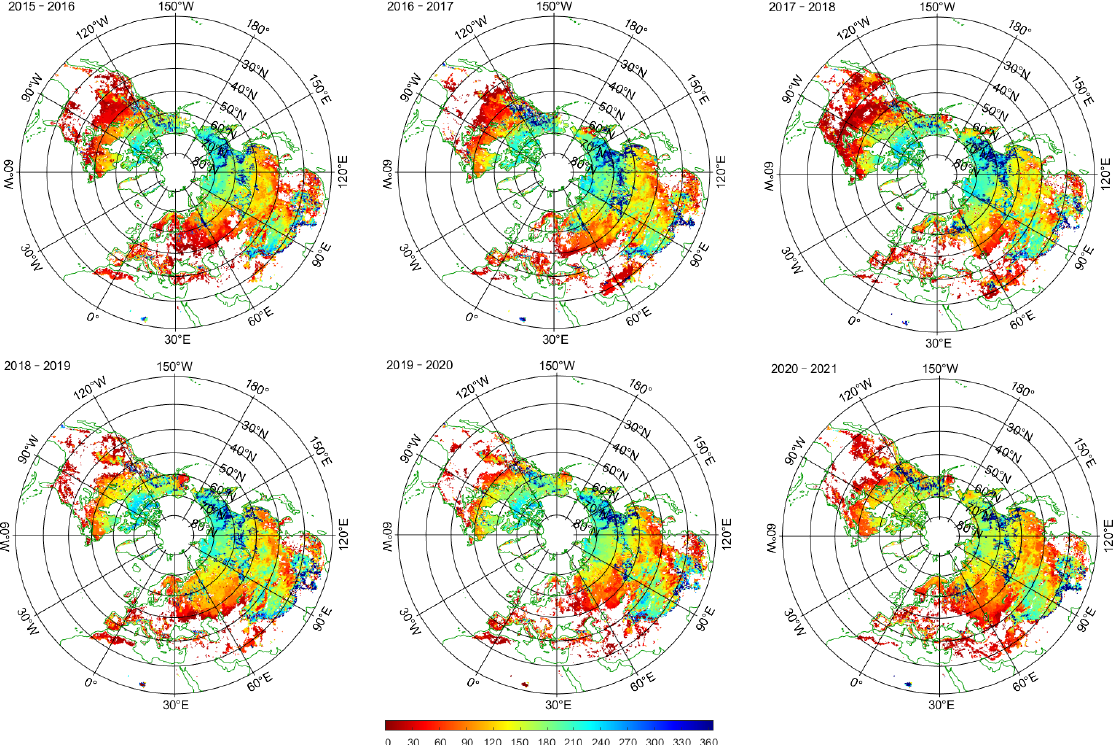
Figure 7. The duration of the frozen period inferred from the SMAP L3 global H-polarization bright- ness temperature product. brightness temperature